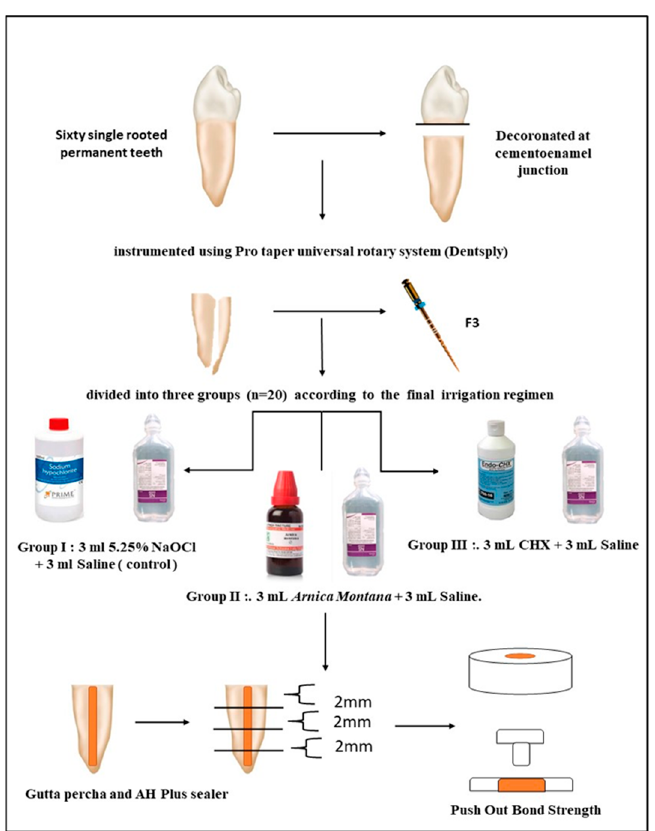
Figure 1. Flow chart of the study. (NaOCl: Sodium hypochlorite; CHX: Chlorhexidine; mL: milliliters; and mm: millimeters)